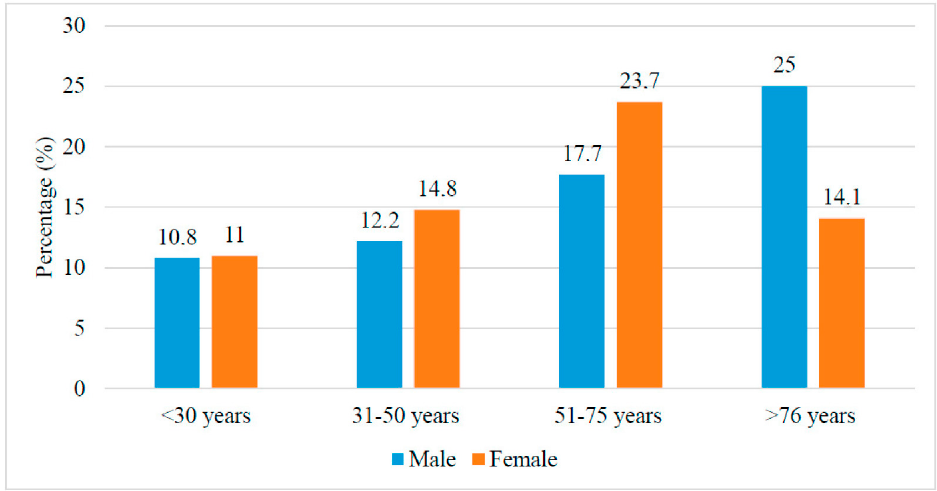
Figure 1. Major low anterior resection syndrome (LARS) prevalence comparison according to age and sex ( p < 0.05). Table 3 represents statistically significant risk factors for minor LARS. Multivariate logistic regression of the entire study population showed that male sex was an independ-